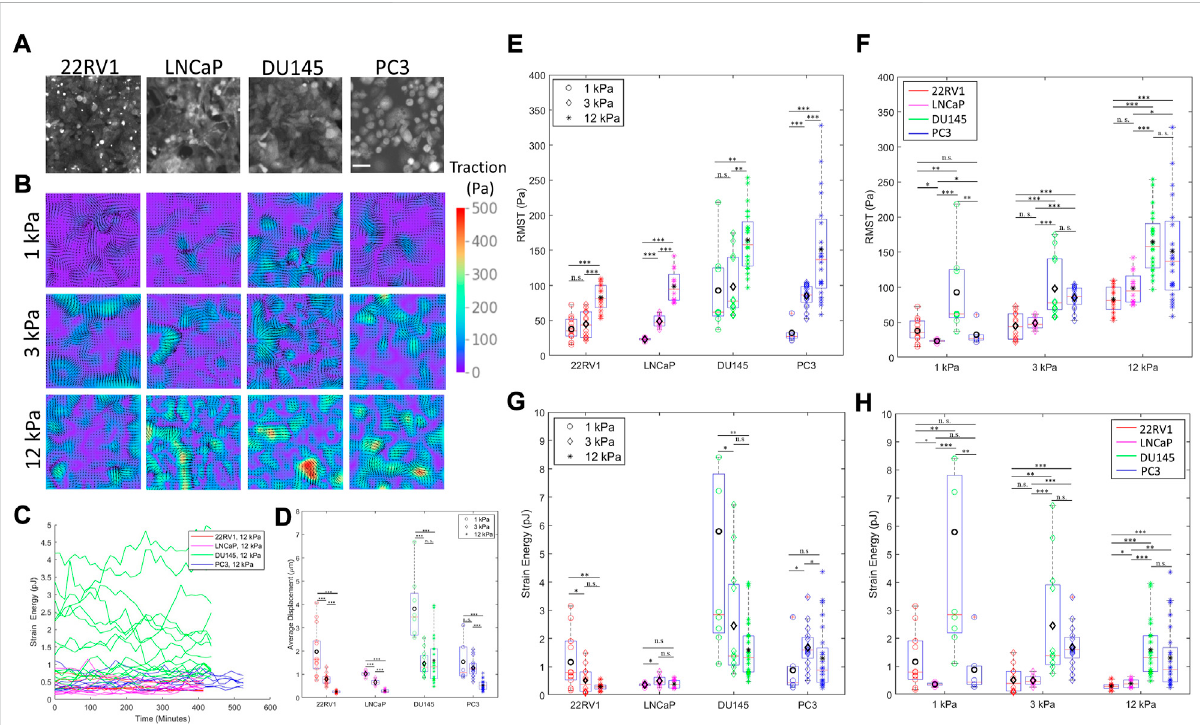
FIGURE 1 Prostate cancer cells withvarying metastatic potential displayuniquesubstratestiffness-dependentmonolayercontractility. (A) Representative prostate cancer (PCa) monolayers of increasing metastatic potential (22RV1, LNCaP, DU145, and PC3) on 3 kPa substrates labelled with CellTracker Orange CMTR cell dye. (B) Representative traction maps generated by monolayers of increasing metastatic potential on substrates of increasing stiffness. (C) Representative time traces of measured contractile metrics (here strain energy) for individual monolayers. (D) Time-averaged surface displacement exerted by the cell monolayer to its underlying substrate, as measured using a traction force microscopy cross-correlation algorithm. Average displacement measurements converged to similar values approaching the noise level on 50 kPa substrates, suggesting that the 50 kPa substrate is too stiff to resolve cell deformations, restricting our analysis to contractility on 1 – 12 kPa. (E – F) Root mean-squared traction (RMST)stressofPCacelllines cultured onsubstrates ofvarioussubstratestiffnesses,grouped accordingtocell type (E) and stiffness (F) . (G – H) Strain energy of PCa cell lines cultured on substrates of various substrate stiffnesses, grouped according to cell type (G) and stiffness (H) . Scale bar in (A) is 50 μ m.Blackmarkerson (D – H) indicatethemeanvalues.StatisticswerecalculatedusingapairwiseMann – WhitneyUtestwhere* p < 0.1;** p < 0.01; *** p < 0.001. Pairwise statistical comparisons across all groups for average displacement, RMST, and strain energy may be found in Supplementary Tables S2, S3, and S4,